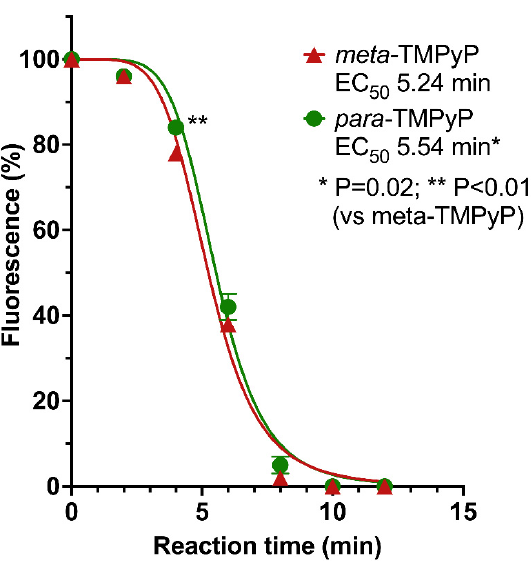
Figure 4. Generation of singlet oxygen by meta -TMPyP and para -TMPyP as detected by ABDA reaction test. Both TMPyP variants were exposed to LED light under the same conditions as in PDI experiments (0.78 J/cm 2 per minute). Generation of singlet oxygen time-dependently led to a reduced fluorescence of remaining ABDA substrate. For meta -TMPyP , the half-maximal reduction of fluorescence was calculated to be reached only slightly earlier (18 s) than for para -TMPyP , with a small, but significant, difference in fluorescence detected only at 4 min reaction time.